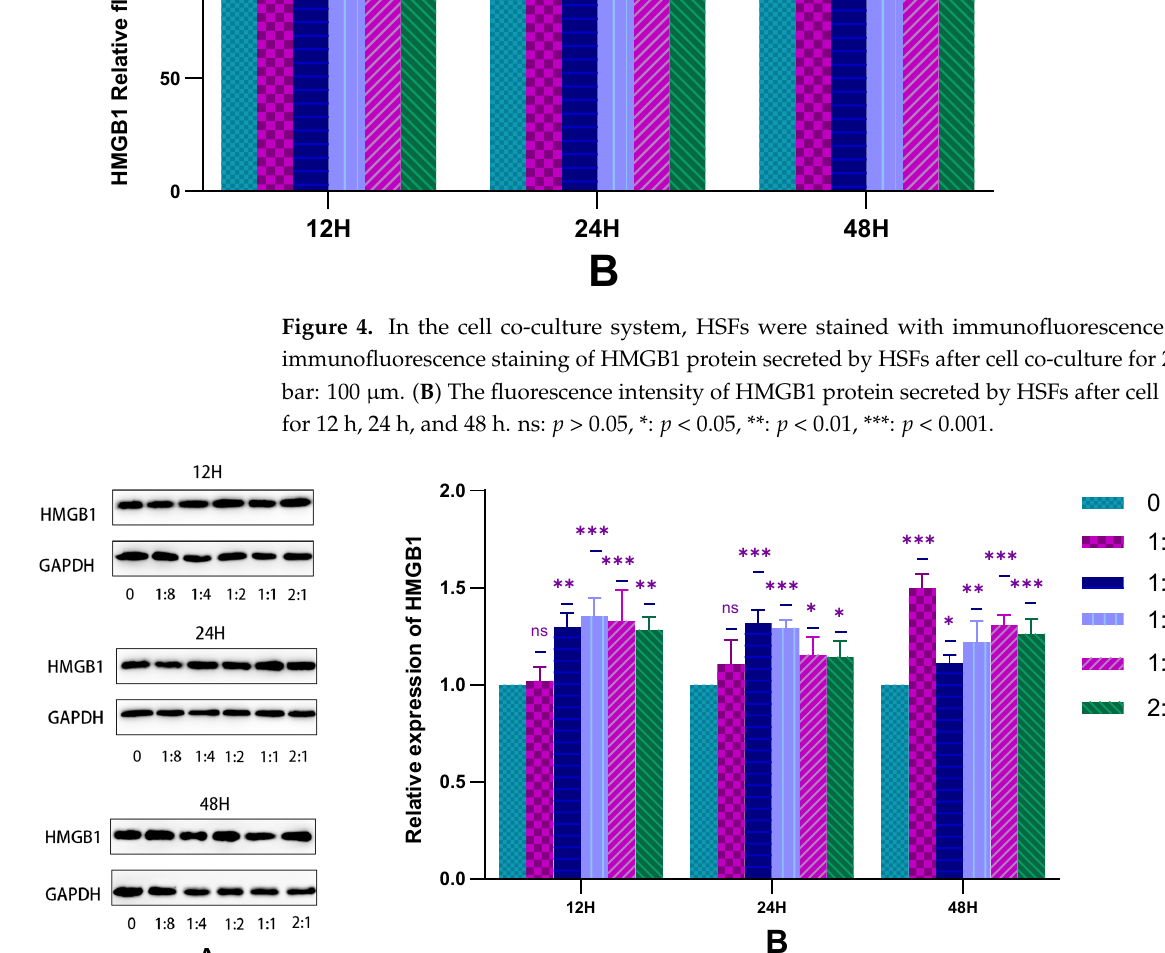
Figure 4. In the cell co-culture system, HSFs were stained with immunofluorescence. ( A ) The im- munofluorescence staining of HMGB1 protein secreted by HSFs after cell co-culture for 24 h. Scale bar: 100 μm. ( B ) The fluorescence intensity of HMGB1 protein secreted by HSFs after cell co-culture for 12 h, 24 h, and 48 h. ns: p > 0.05, *: p < 0.05, **: p < 0.01, ***: p < 0.001.